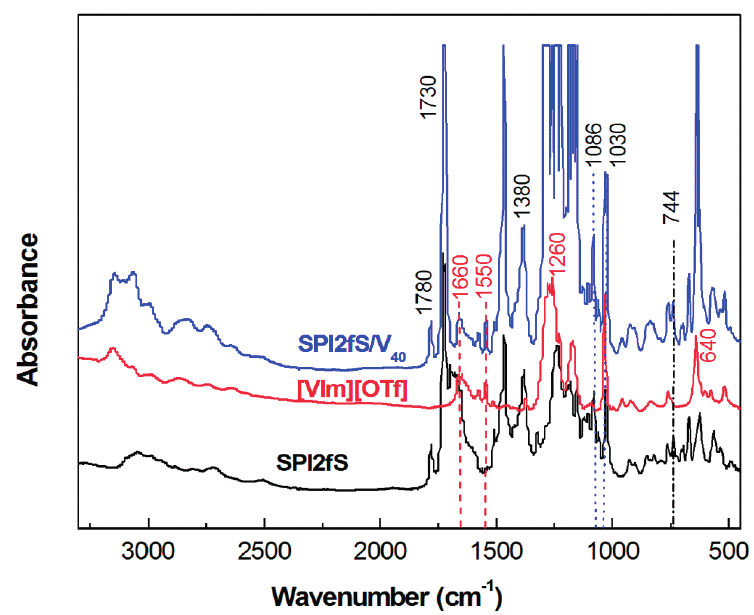
Figure 3. FTIR spectra of SPI2fS, [VIm][OTf], and its SPI/PIL composite